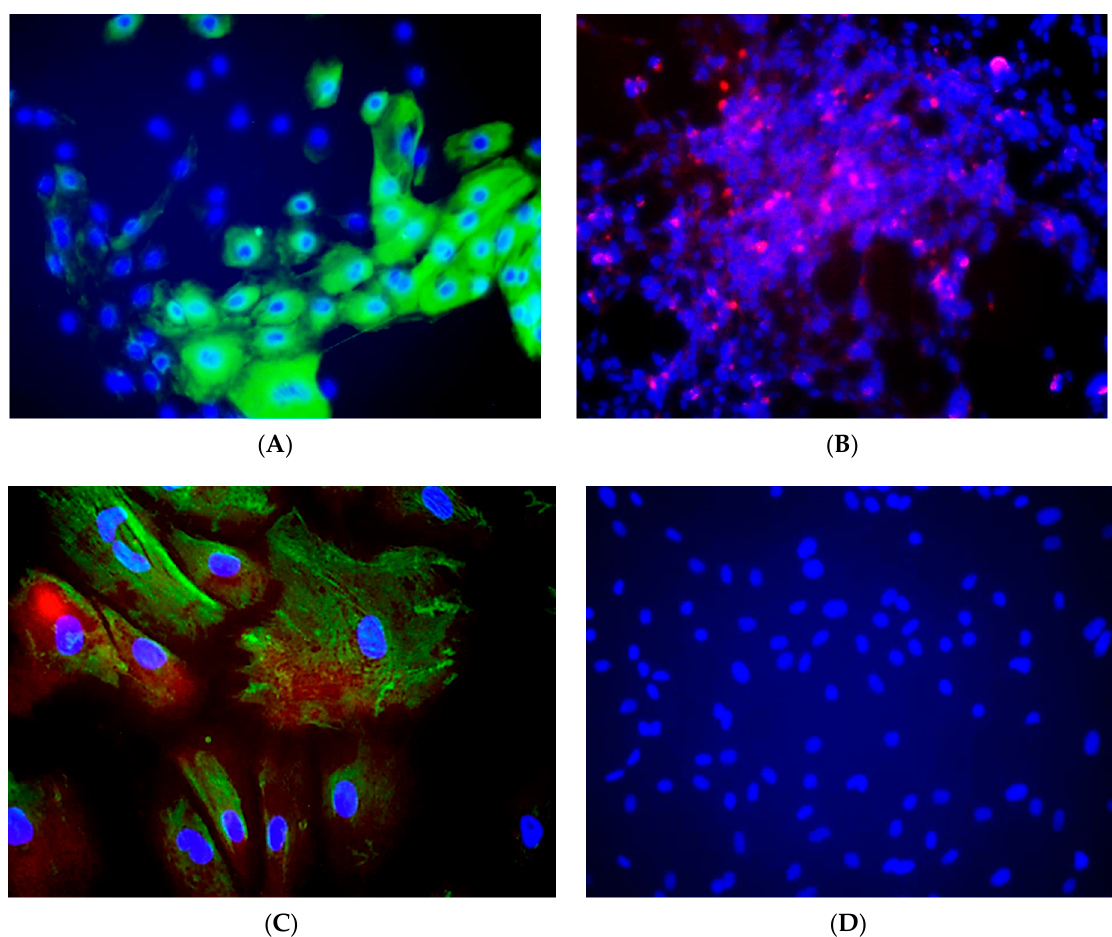
Figure 1. Immunostaining of CAEV antigen and the cytokeratin epithelial marker in milk epithelial cells originated from goats examined in this study. ( A ) single cytokeratin labeling (green color) ( B ) single CAEV p28 labeling (red color) ( C ) double CAEV p28 (red color) and cytokeratin (green color) labeling on the same samples ( D ) cells stained by omitting the primary antibody incubation during labeling.